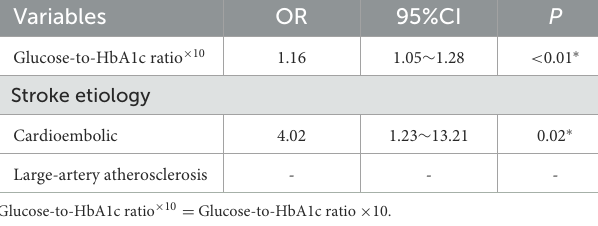
TABLE 3 Independent predictors of a moderate-to-severe stroke at admission in binary logistic regression analysis.